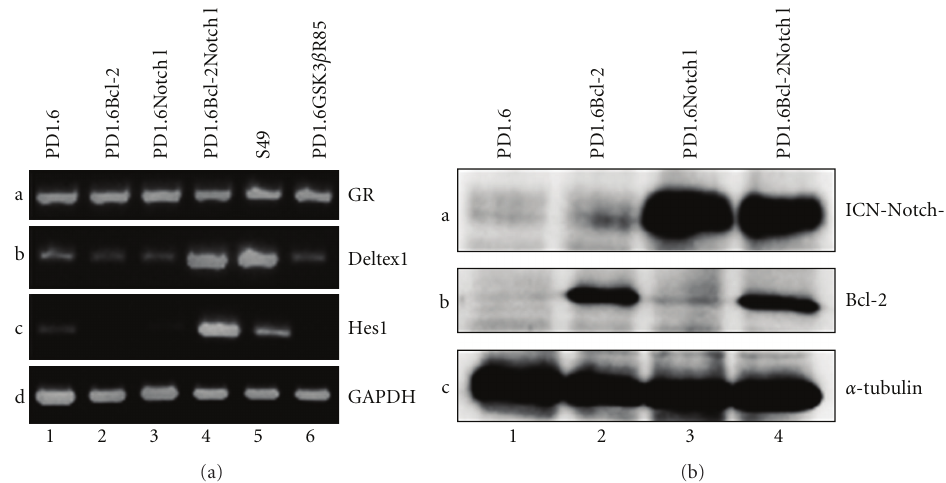
Figure 1: (a) Induction of Deltex1 and Hes1 expression in PD1.6 cells overexpressing both ICN-Notch1 and Bcl-2. Reverse transcriptase- polymerase chain reaction (RT-PCR) analysis of the indicated cells. GAPDH was used as loading control. (b) Western blot analysis of Bcl-2 and Notch1 expression in PD1.6, PD1.6Bcl-2, PD1.6Notch1, and PD1.6Bcl-2Notch1 cells. α -Tubulin was used as loading control.